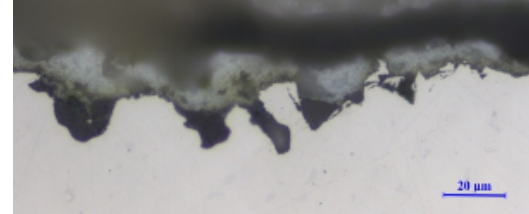
Figure 4. Penetration of ceramic